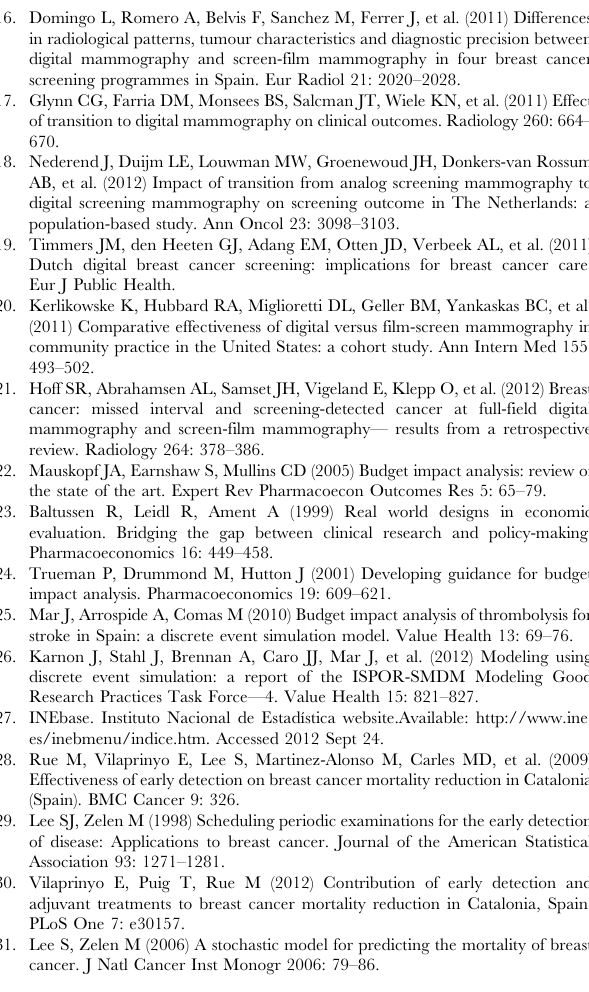
Table S1 Beta distributions for probabilistic sensitivity analysis. Table S2 Parameters of the Dirichlet distributions for cancer detection stages by age, detection setting, type of mammography and screening